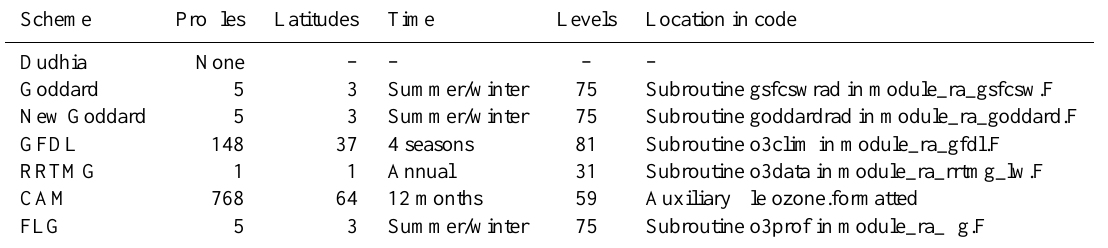
Table 1. Description of the ozone profiles in the shortwave schemes in the WRF-ARW model. The Dudhia scheme is not analyzed in this study for reasons mentioned in the